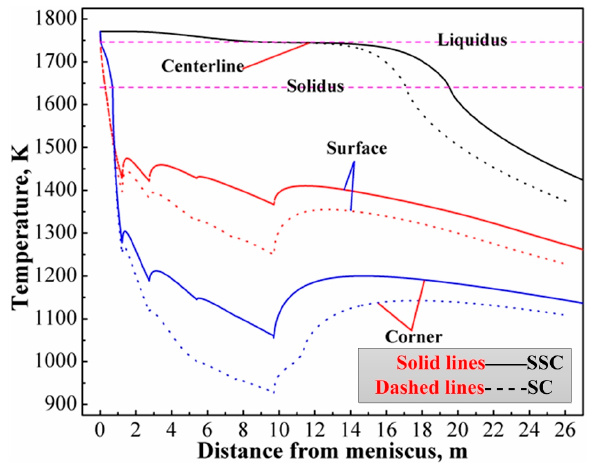
Figure 7. Center, surface and corner temperature variations along casting direction for SSC and SC.